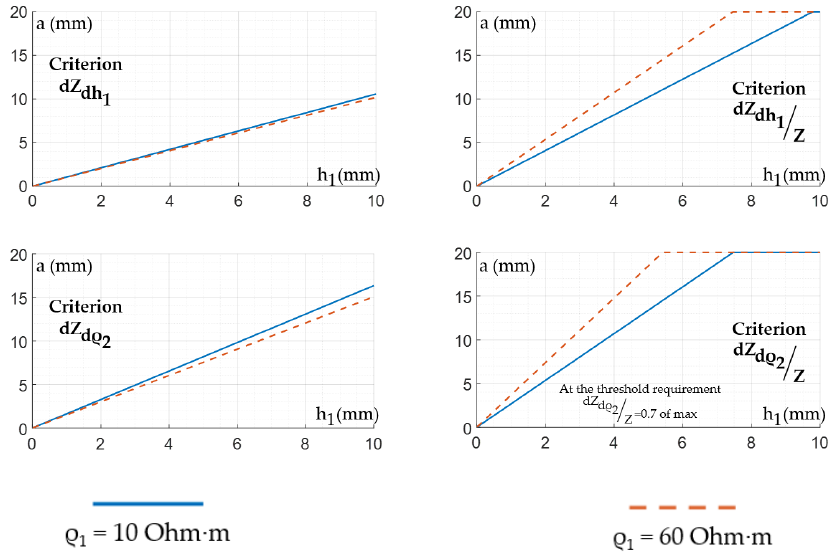
Figure 11. Relationship between the interelectrode distance values and the skin-fat layer thickness.